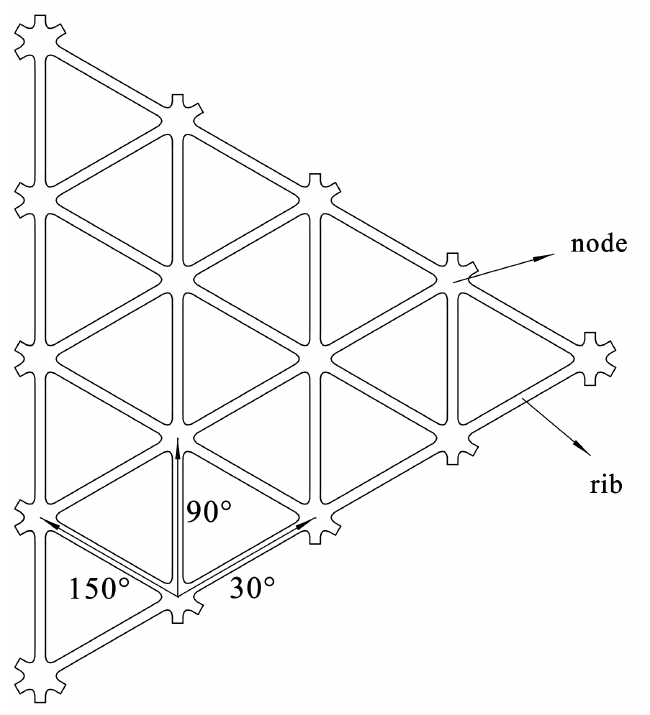
Figure 1. Basic structure of triaxial geogrid. Compared with a biaxial geogrid with ribs only at 0° and 90°, a triaxial geogrid has higher tensile strength in more directions. Through experiments, Dong et al. [4] found that the geogrid with triangular holes had a more stable structure and could bear more uniform tensile force in all directions, and used FLAC software to respond to the geogrid with rectangular and triangular holes under uniaxial tensile loads in different